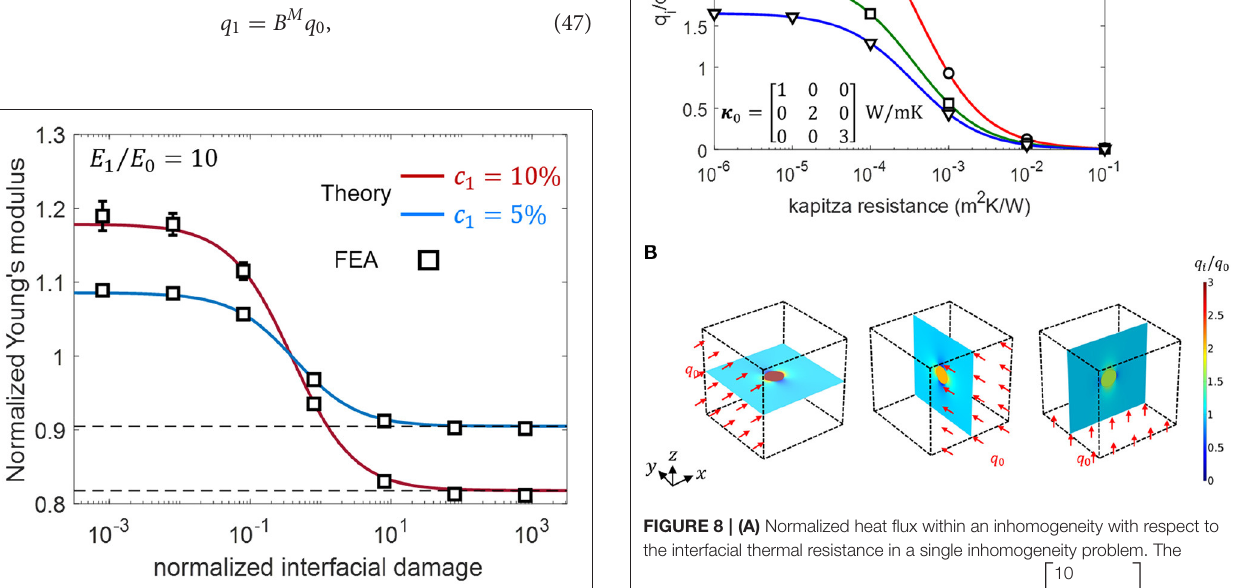
10 W / mK. (B) 10  =  10    